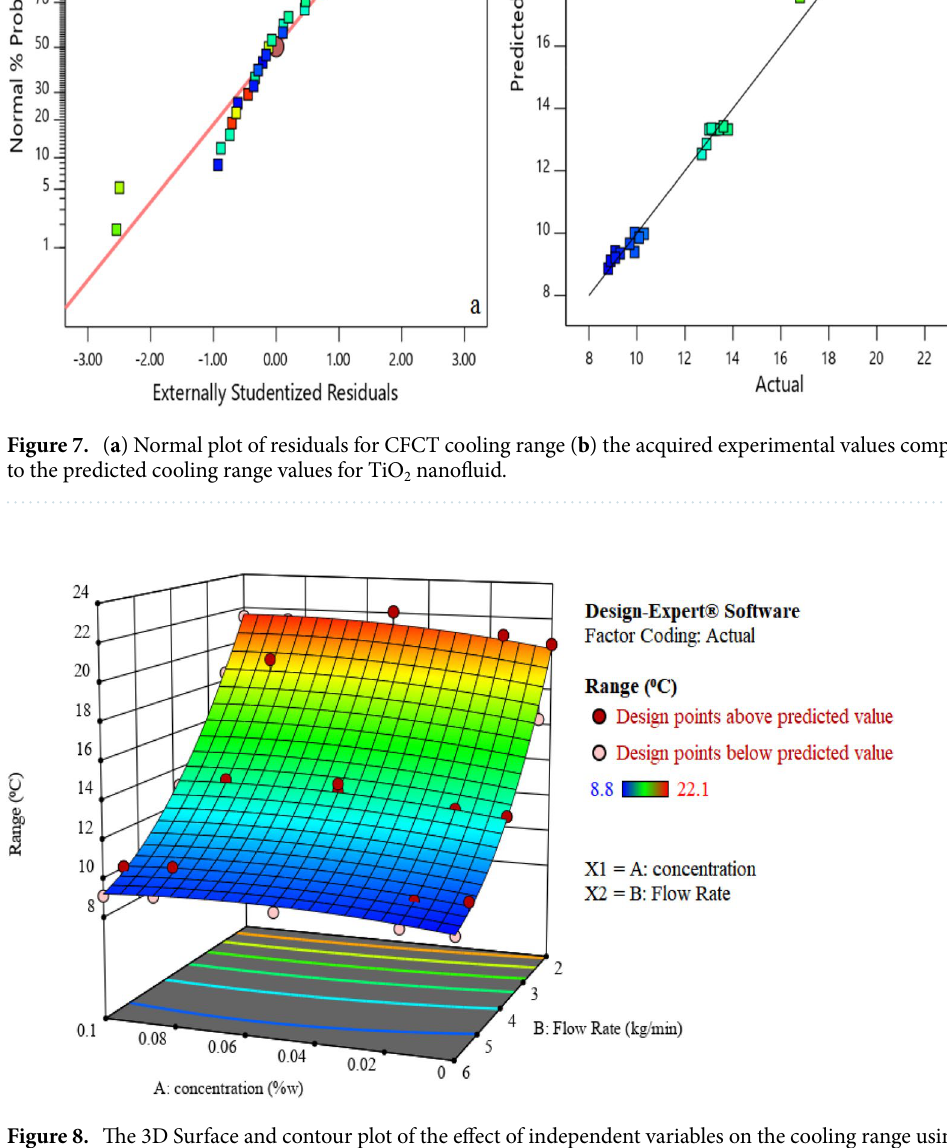
Figure 8. The 3D Surface and contour plot of the effect of independent variables on the cooling range using